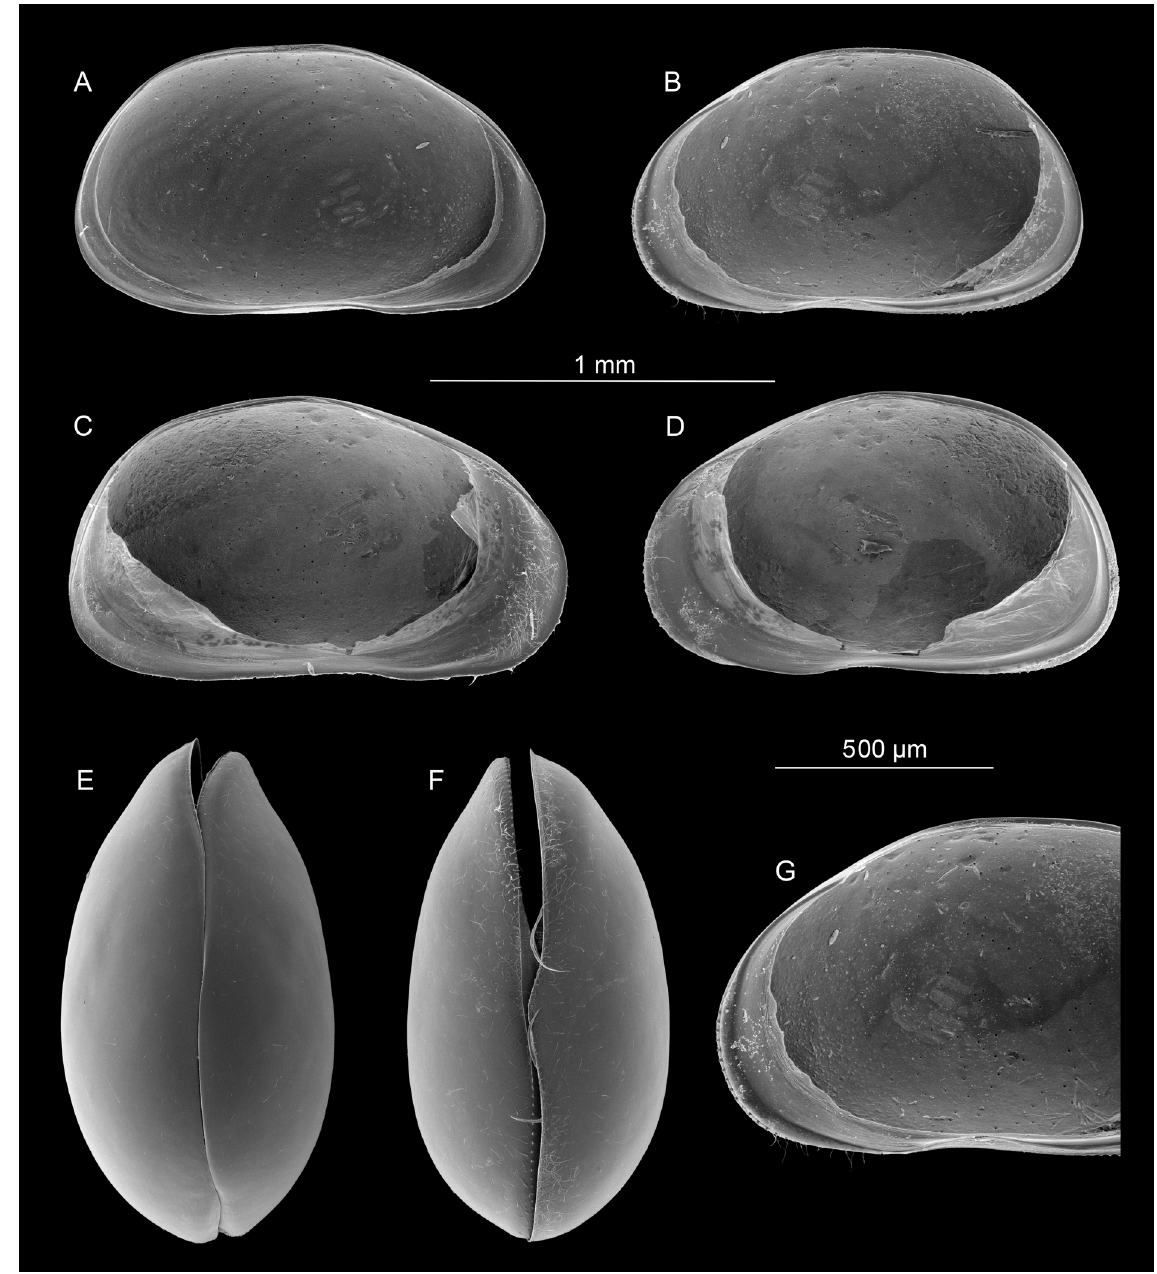
Fig. 10. Bilocypris mandoraensis gen. et sp. nov., Mandora Marsh (type locality). A . LVi, ♂, holotype (WAM 67226). B . RVi, ♂, holotype (WAM 67226). C . LVi, ♀, allotype (WAM 67601). D . RVi, ♀, allotype (WAM 67601). E . CpD, ♀, paratype (WAM 67604). F . CpV, ♀, paratype (WAM 67603). G . RVi, ♂, anterior detail, holotype (WAM 67226). Scales: A–F = 1 mm; G = 500